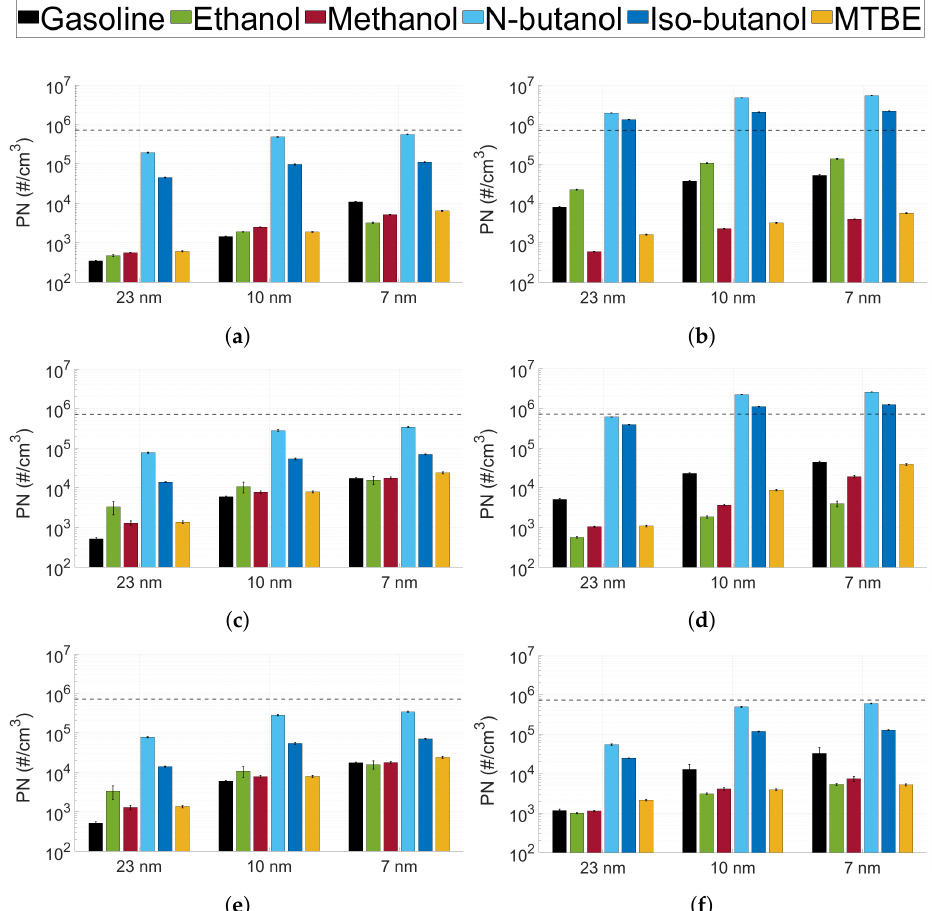
Figure 4. The particle number emissions at different cut-off sizes and different operating conditions measured using the CPCs. The dashed lines show the concentration limit for the CPCs with cut-offs at 23 nm and 10 nm. The error bars show the normalised random error ( ± (cid:101) ). ( a ) 1500 RPM, 7.5 bar IMEP, ( b ) 1500 RPM, 13 bar IMEP,( c ) 2500 RPM, 7.5 bar IMEP, ( d ) 2500 RPM, 13 bar IMEP, ( e ) 3500 RPM, 7.5 bar IMEP and ( f ) 3500 RPM, 13 bar